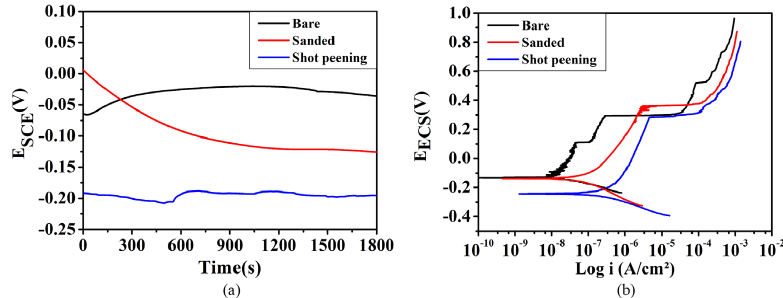
Figure 3. Open circuit potential (OCP) (a) and polarization curves (b) of the samples.